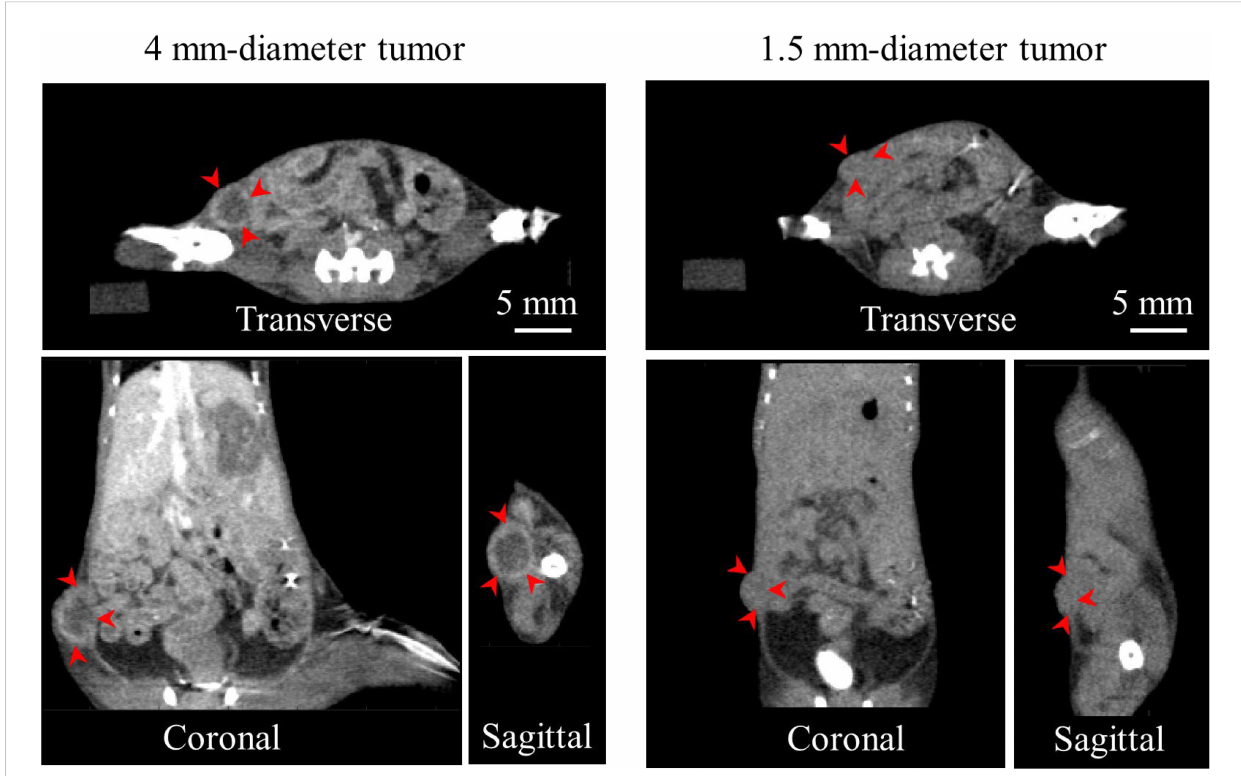
FIGURE 6 Contrast CT slices of 2 (out of 10) mice bearing orthotopic breast tumors of different sizes, in three orthogonal views. Arrows indicate the contrast enhanced tumor